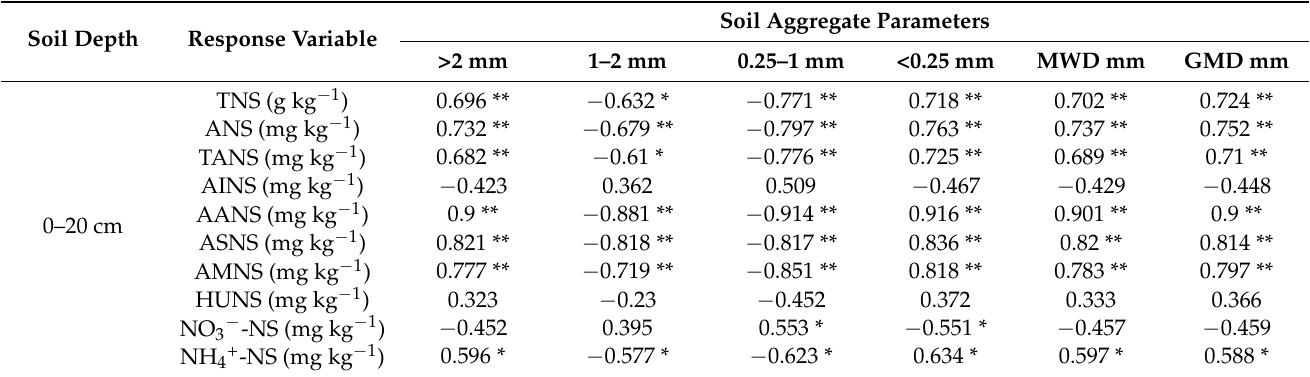
Table 5. Pearson’s correlation of soil N stock and soil aggregate parameters.